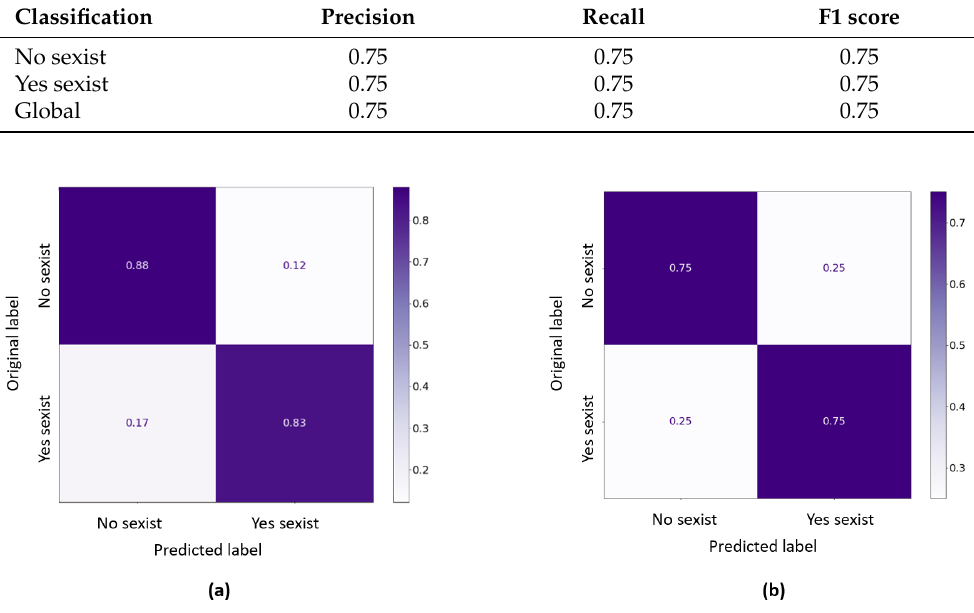
Table 3. Test set: Results for sexist comments, non-sexist comments, and both.